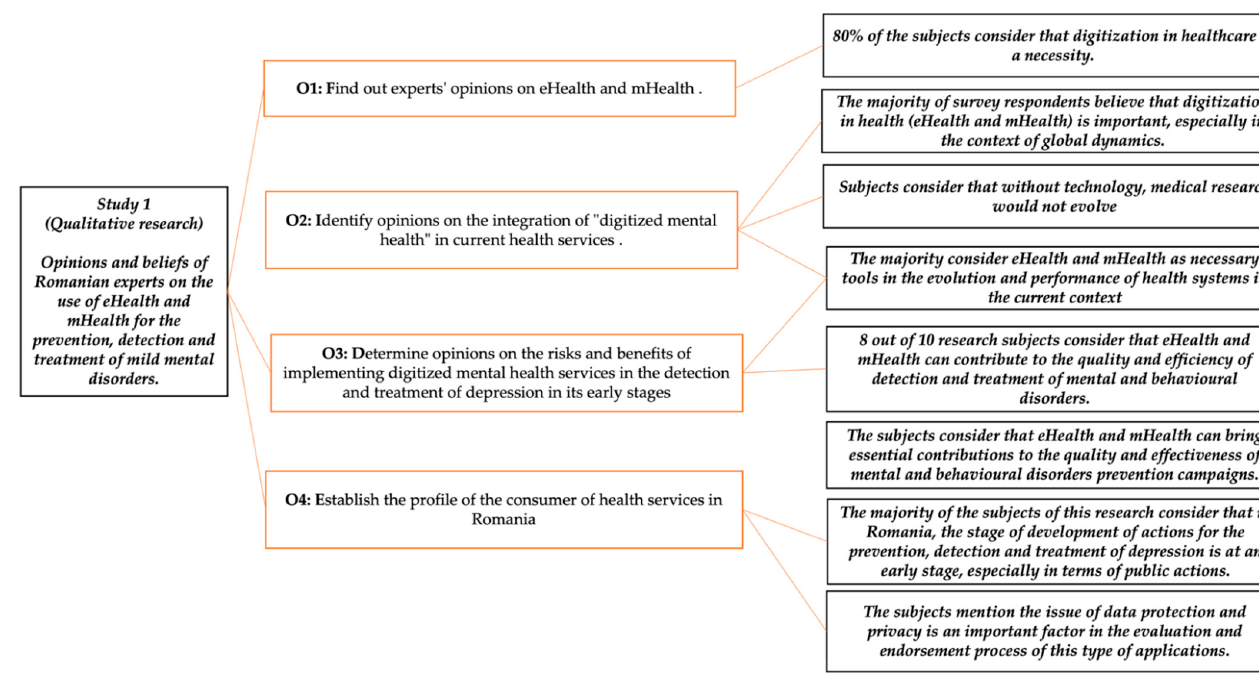
Figure 17. The first study (qualitative research overview).